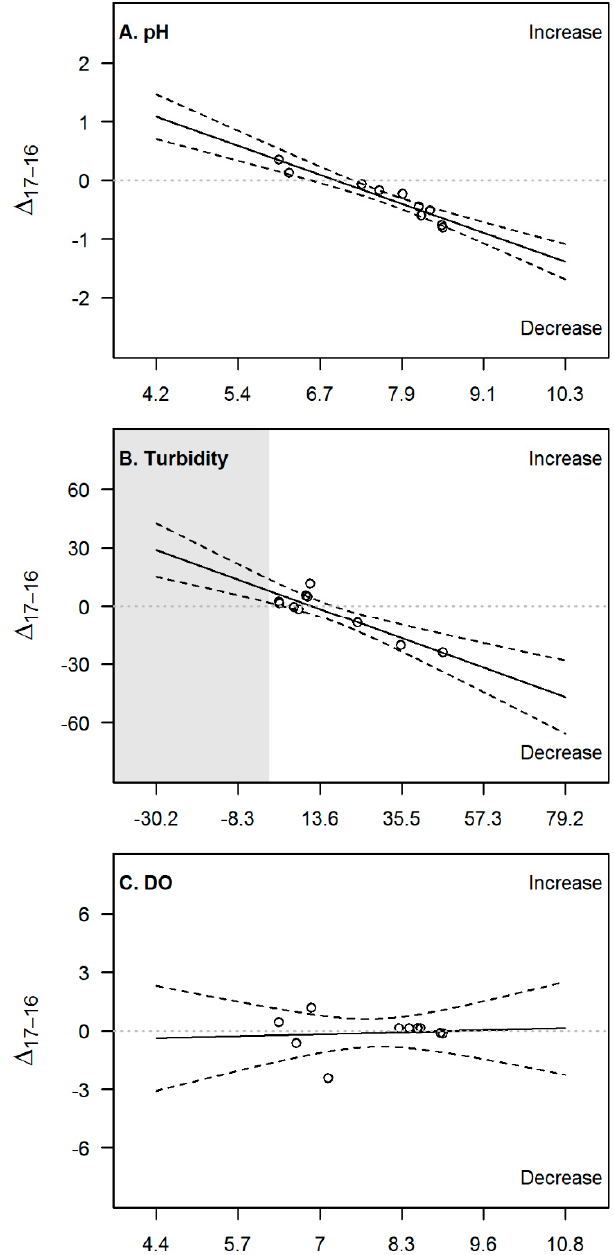
Figure 4. Linear regression lines depicting the change in abiotic variables between 2016 and 2017. Open circles represent the sample sites, the solid black line the fitted trend, and the dotted black lines the confidence (95%) related to it. ( A ) pH (-); ( B ) turbidity (NTU); ( C ) dissolved oxygen (DO, mg L − 1 ). Both pH and turbidity values were characterized by a significant slope ( − 0.49 and − 0.66, respectively, both p < 0.001). The depicted x -range covered 2.5 times the initial range, thereby including negative values (gray zones).